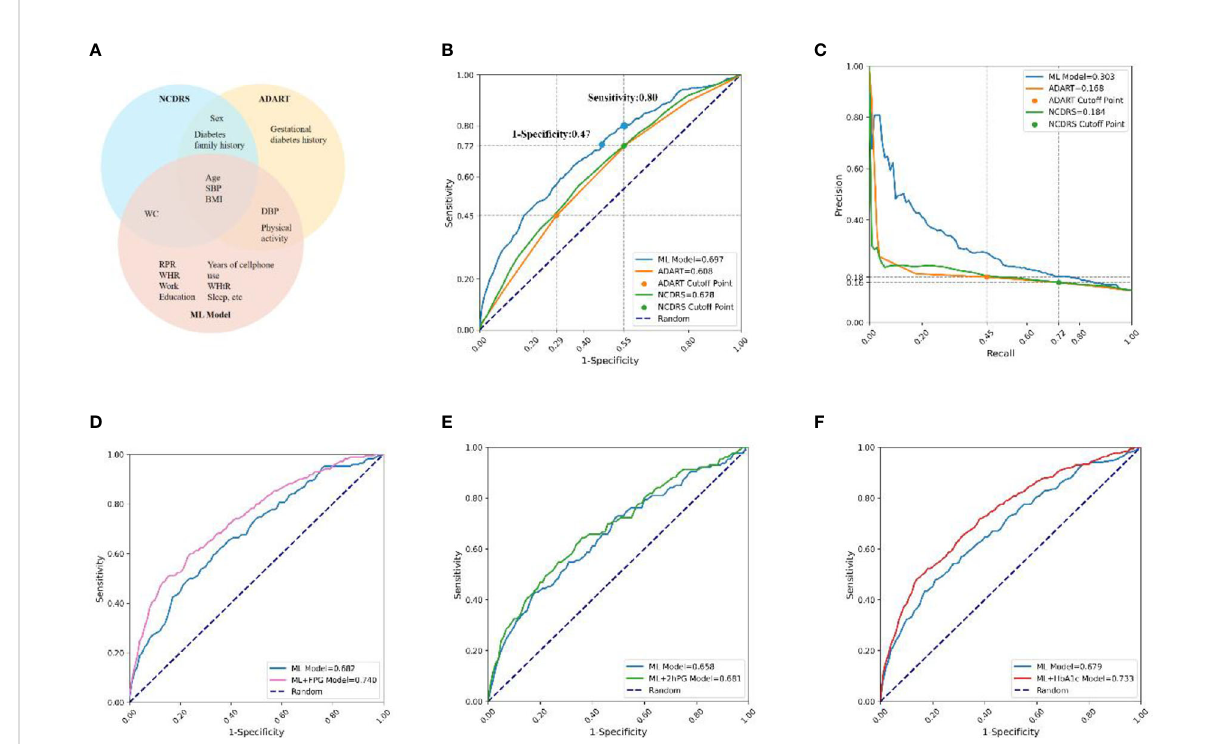
FIGURE 4 Comparisons of features and prediction performance between ML and ML+lab models with their corresponding counterparts. (A) , Compared features between the ML model and ADART and NCDRS. (B, C) , Compared the ROC (B) and PR (C) curves between the ADART, NCDRS, and the ML model. vs AUC (ML model), P< 0·05; the cutoff points of ADART and NCDRS recommended by ADA and CDS (Risk score ≥ 5 and ≥ 25, respectively) were plotted as two points in ROC and PR curve; the corresponding horizontal and vertical coordinate values of these two points are marked on the coordinate axis. (D – F) , Compared the ROC curves between the ML model with ML+FPG model (D) in individuals with seemingly normal FPG levels (P< 0·05), ML+2hPG (E) model in individuals with seemingly normal 2hPG levels (P> 0·05), and ML+HbA1c model (F) in individuals with seemingly normal HbA1c levels (P< 0·05). ADA, America Diabetes Association; CDS, Chinese Diabetes Society; ADART, ADA risk test; NCDRS, New Chinese Diabetes Risk